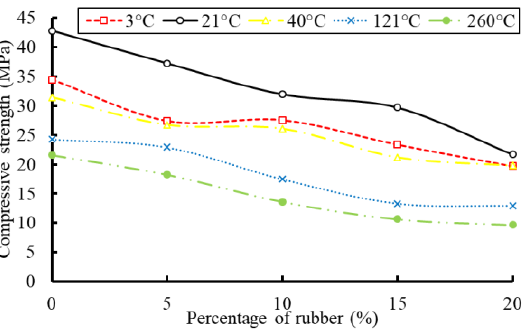
Figure 17. Effect of CR content on compressive strength at different temperatures.